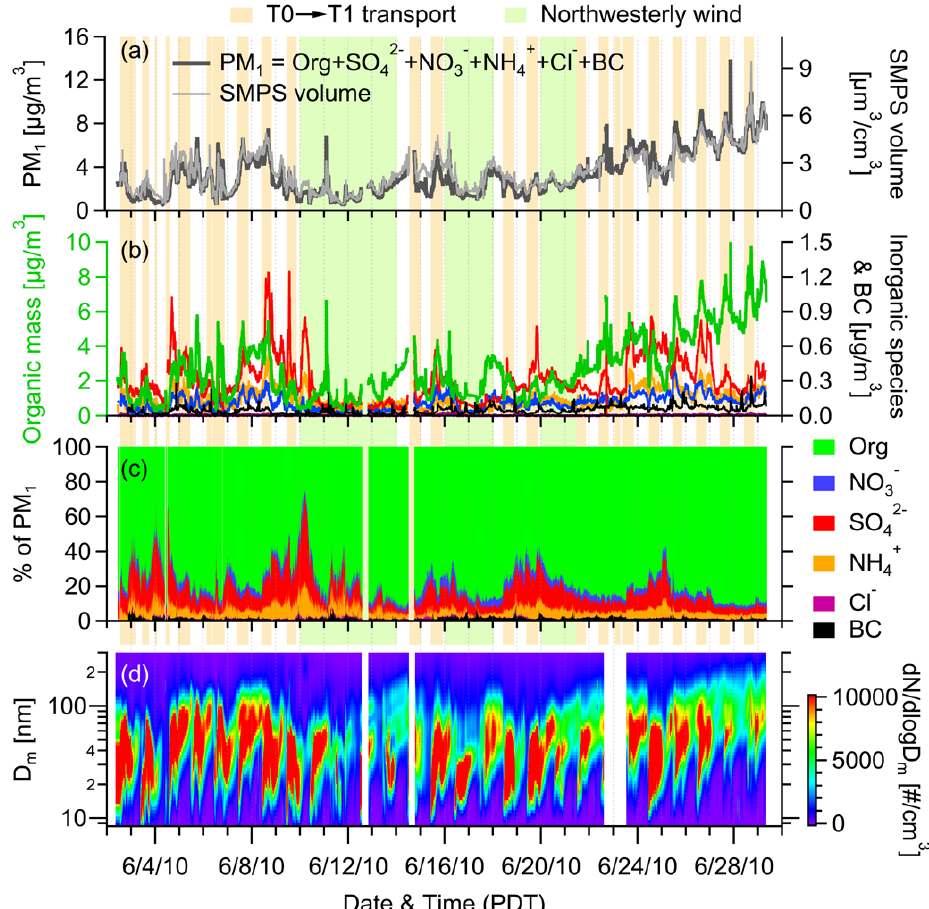
Fig. 2. Time series of (a) AMS total mass + BC and SMPS volume concentrations, (b) concentrations of organics (left y-axis), sulfate, nitrate, ammonium, chloride, and BC (right y-axis), (c) percentage contribution of the species to the total PM 1 mass, and (d) particle number size distribution by the SMPS. BC data is not available before 3 June 2010, so PM 1 concentrations before this date correspond to the sum of NR-PM 1 (AMS species). Shaded regions indicate 23 periods of urban plumes transported from T0 to T1 (orange) and 3 periods subjected to influences from northwesterly wind (green). The remaining periods correspond mainly to downslope flows from the Sierra Nevada to the